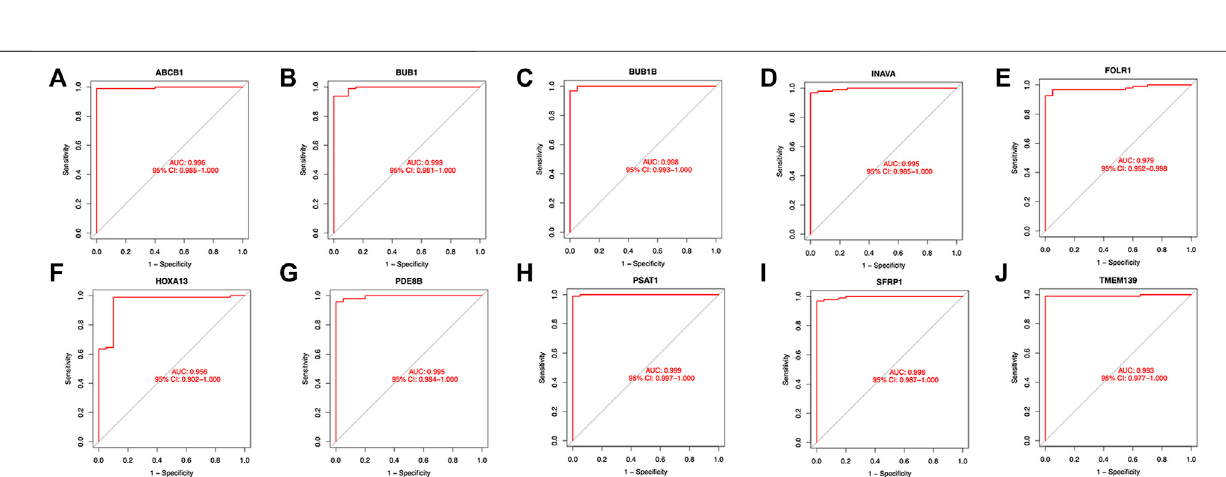
Frontiers in Genetics |